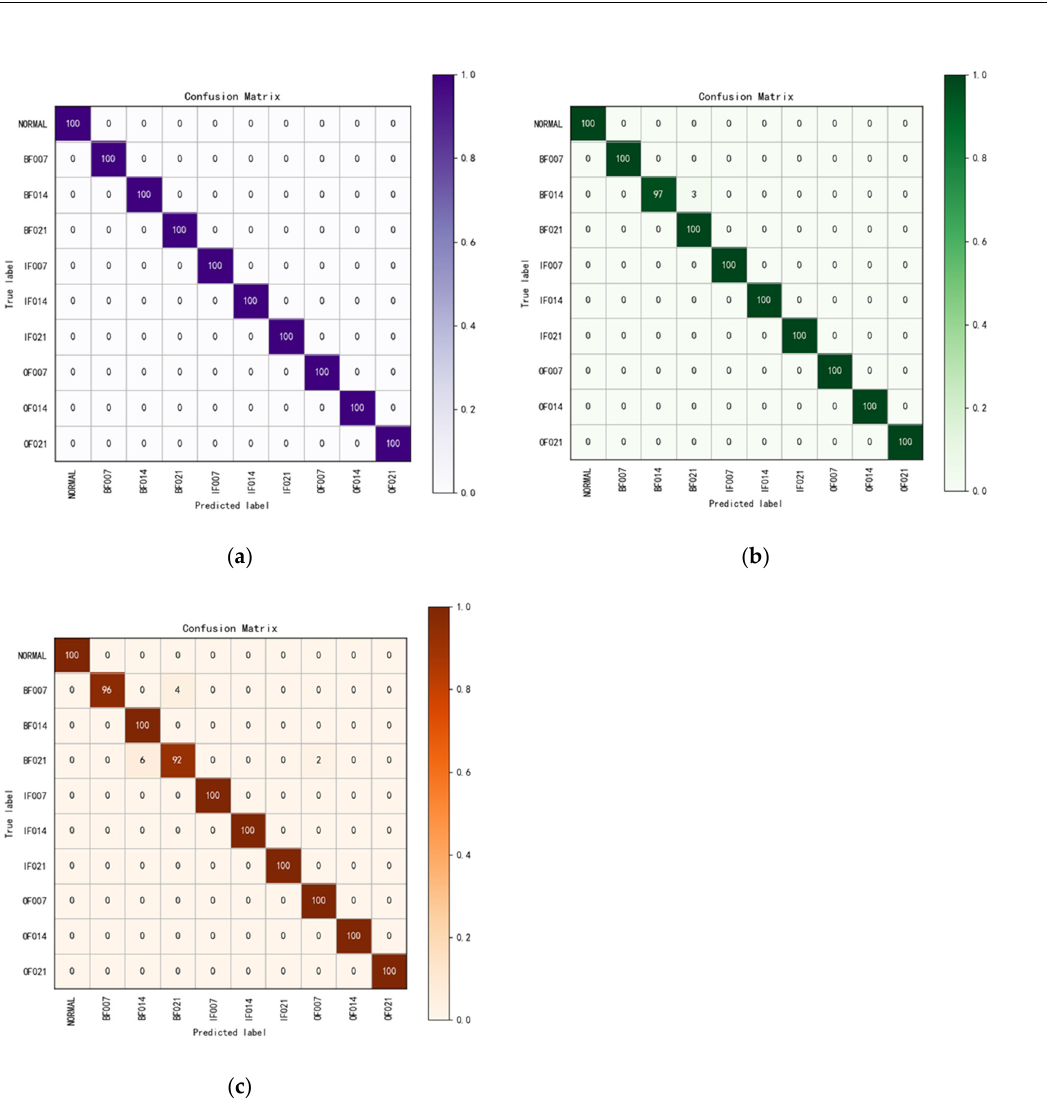
Figure 6. Confusion matrix of different datasets: ( a ) the result of Dataset A; ( b ) the result of Dataset B; ( c ) the result of Dataset C.